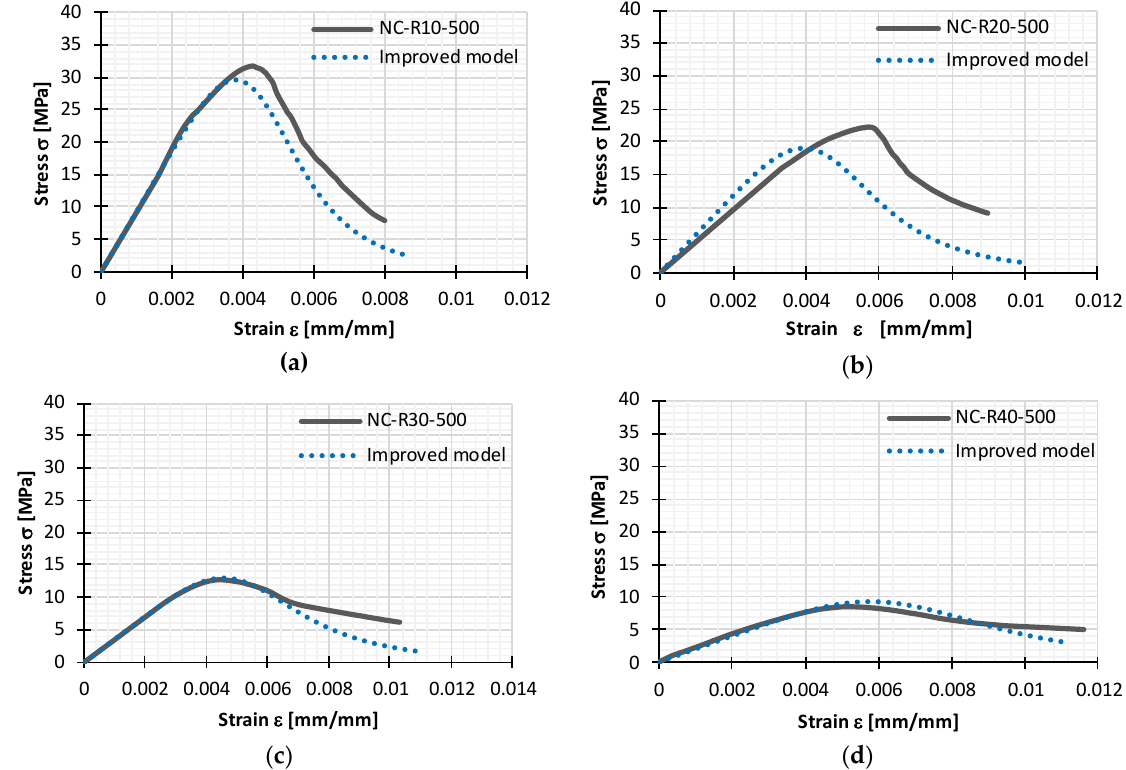
Figure 11. Comparison of experimental stress-strain curves for ( a ) NC-R0-500; ( b ) NC-R10-500; ( c ) NC-R30-500; and ( d ) NC-R40-500 with the improved constitutive model.